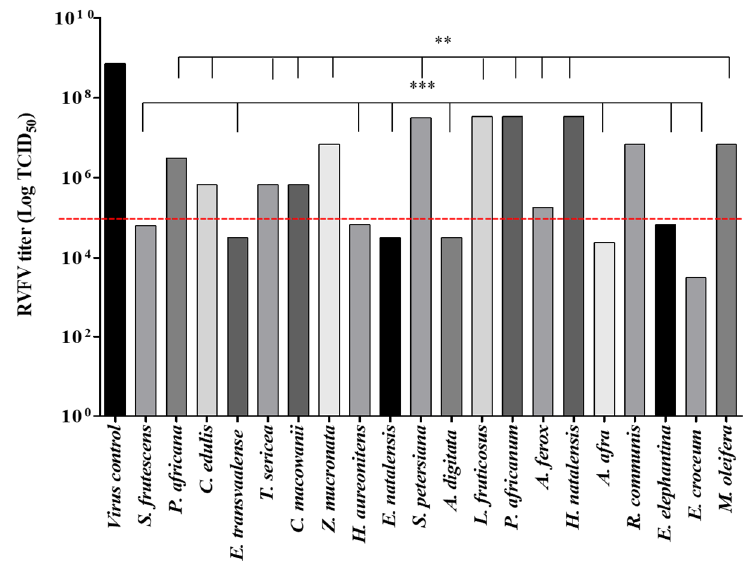
Figure 1. Effects of plant extracts on the RVFV tissue culture infectious dose (TCID 50 ). The red dotted horizontal line shows the limit of viral susceptibility/resistance to extracts. The data represent the means ± SD from three independent experiments. A one-way ANOVA and Duncan’s test for multiple comparisons were used for the statistical analysis (** p < 0.01; *** p < 0.001).